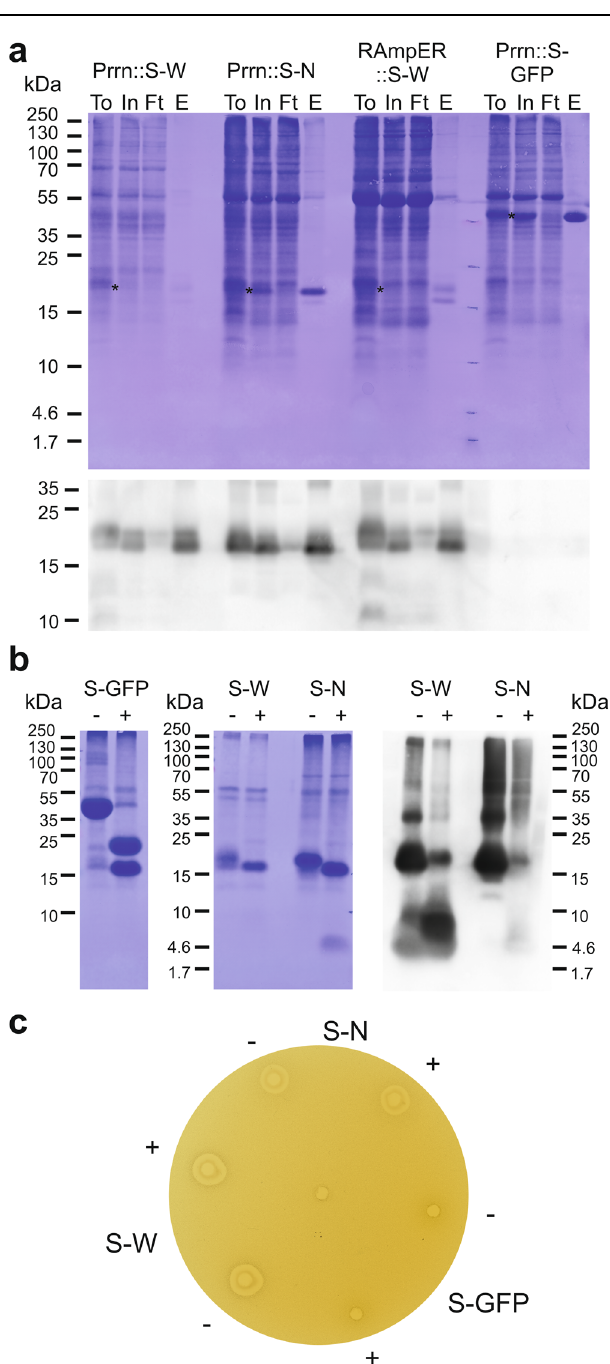
Fig. 7 | Puri fi cation and antimicrobial activity of SUMO-AMP fusion proteins from transplastomic plants. a Ni-NTA agarose puri fi cation of SUMO-AMP and SUMO-GFPfusionproteinsbasedonthe6xHistag.Proteinsampleswereseparated by gel electrophoresis and blotted. The western blot was stained with